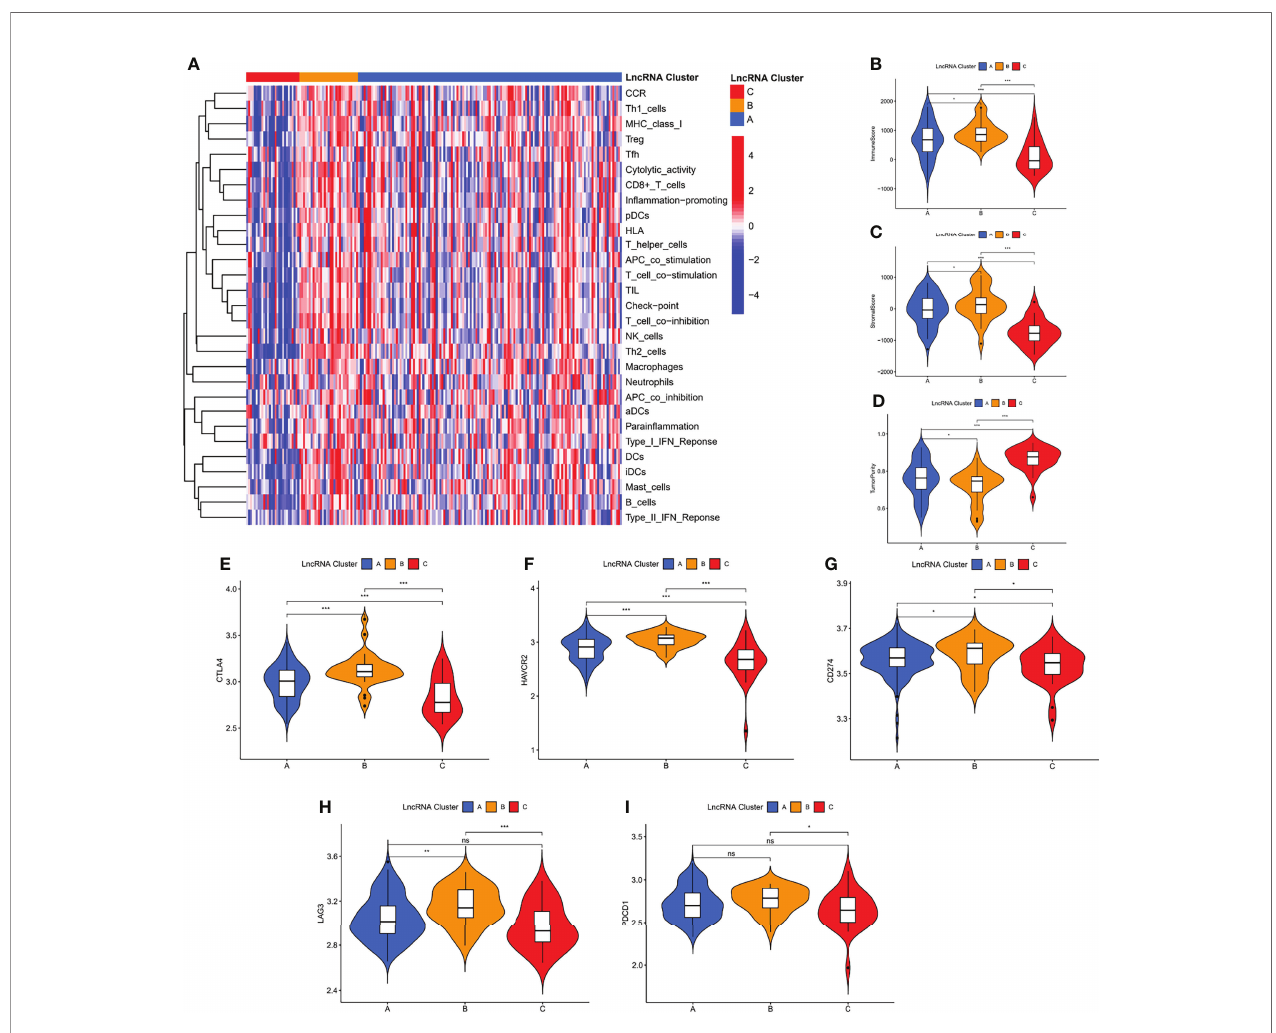
FIGURE 3 | Immunological characterization of m7G-associated lncRNA molecular clusters. (A) Heat map of differences in immune cell in fi ltration between different clusters. The expression level of the immune score (B) , stromal score (C) , and tumor purity (D) , between different clusters. (E – I) The expression levels of immune checkpoint genes between different subtypes. * P < 0.05, ** P < 0.01, *** P < 0.001, ns, not signi fi